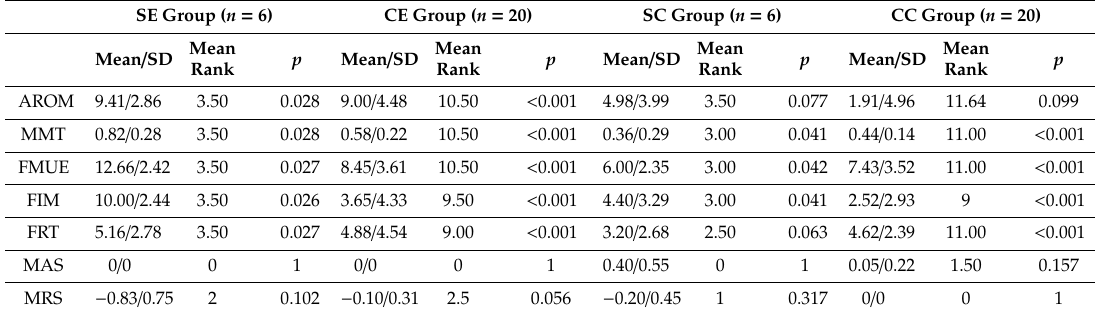
Table 2. Wilcoxon Signed-Rank test, pre- and